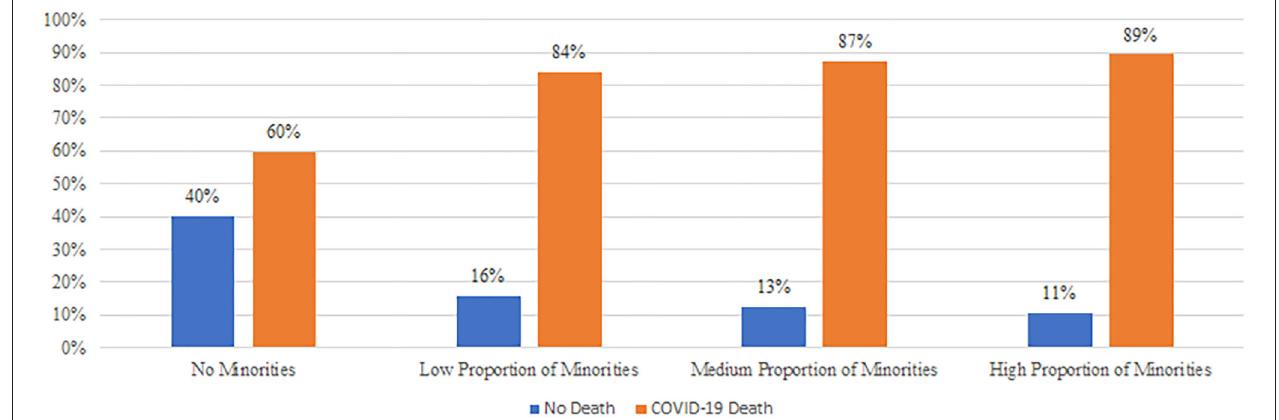
FIGURE 1 | Nursing homes with COVID-19 death by resident racial/ethnic composition ( n = 12,914). Source: Centers for medicare and medicaid services’ nursing home COVID-19 public Blacks/Hispanics: Low proportion of minorities (0 < minority > 13.3); Medium proportion of minorities (13.3 < minority < 30.3); High proportion of minorities (30.3 <